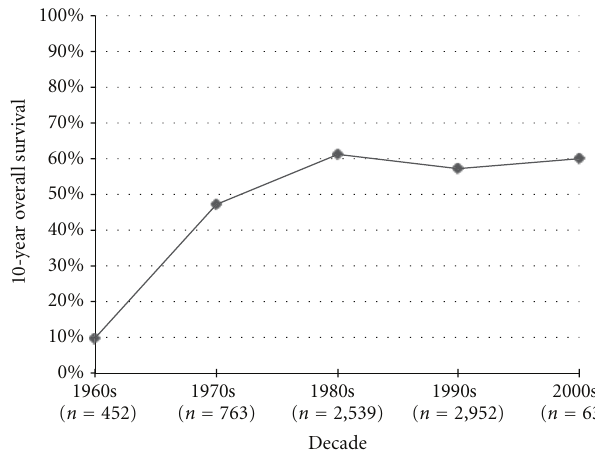
Figure 2: Osteosarcoma 10-year overall survival.